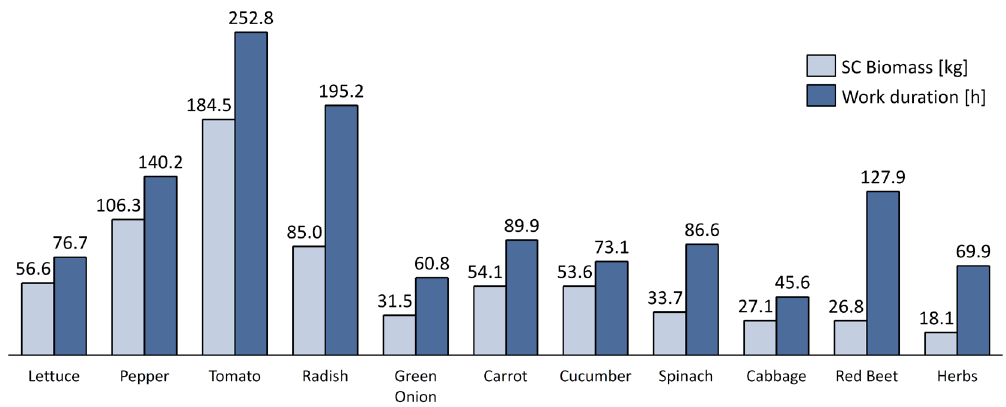
Figure 18: Overall biomass (kg) in comparison to necessary gross work time [h] for the SC approach.